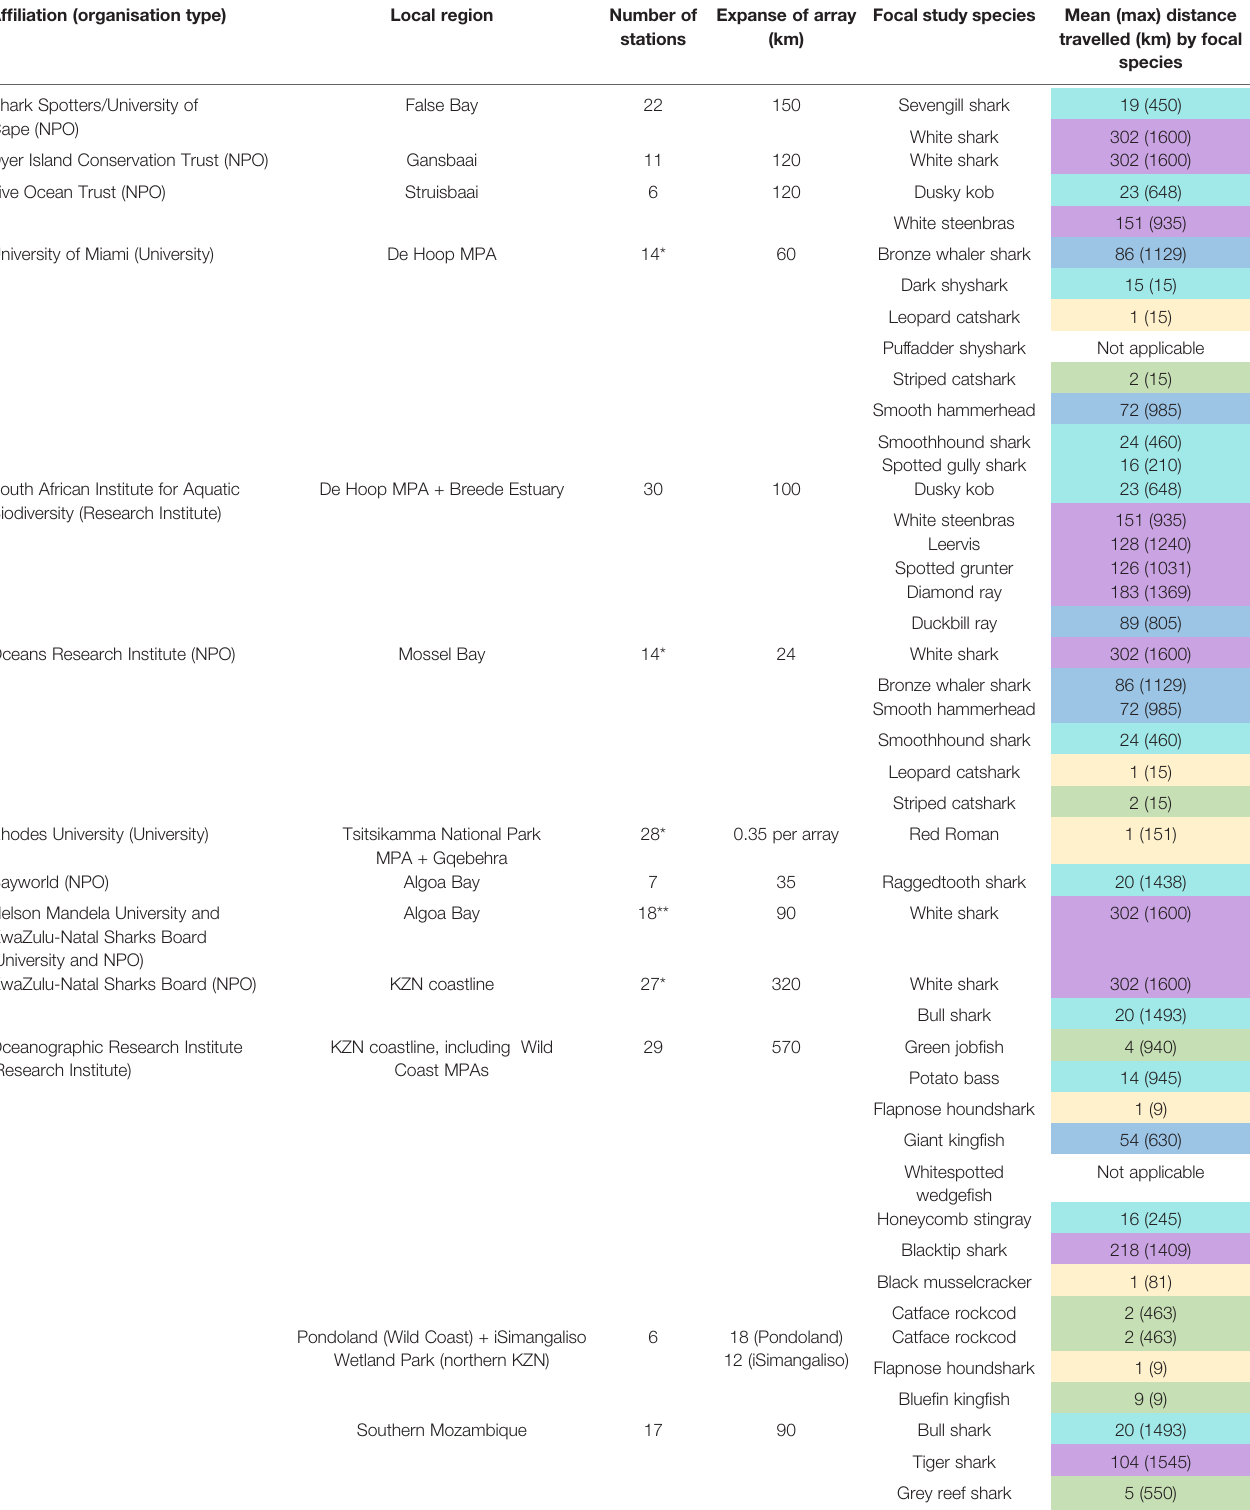
TABLE 2 | Organisational names (and type) of ATAP collaborators who run their own smaller local networks along the South African coastline, details of the networks, and the focal study species for which the network was initially